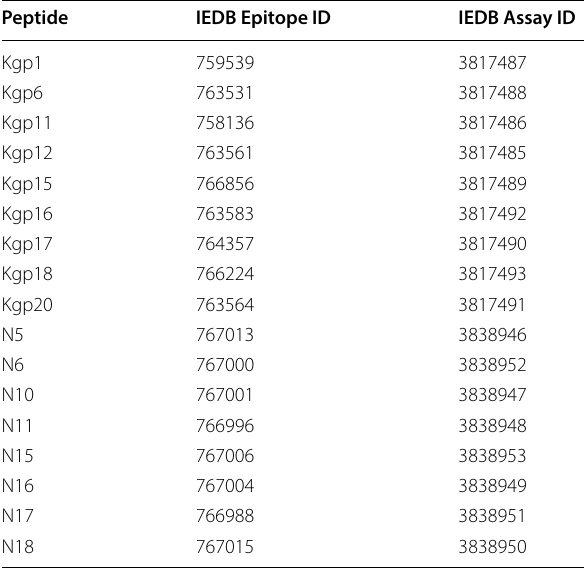
Table 4 Immune Epitope Database (IEDB) identifiers of the tested peptides (Brazil, 2018)